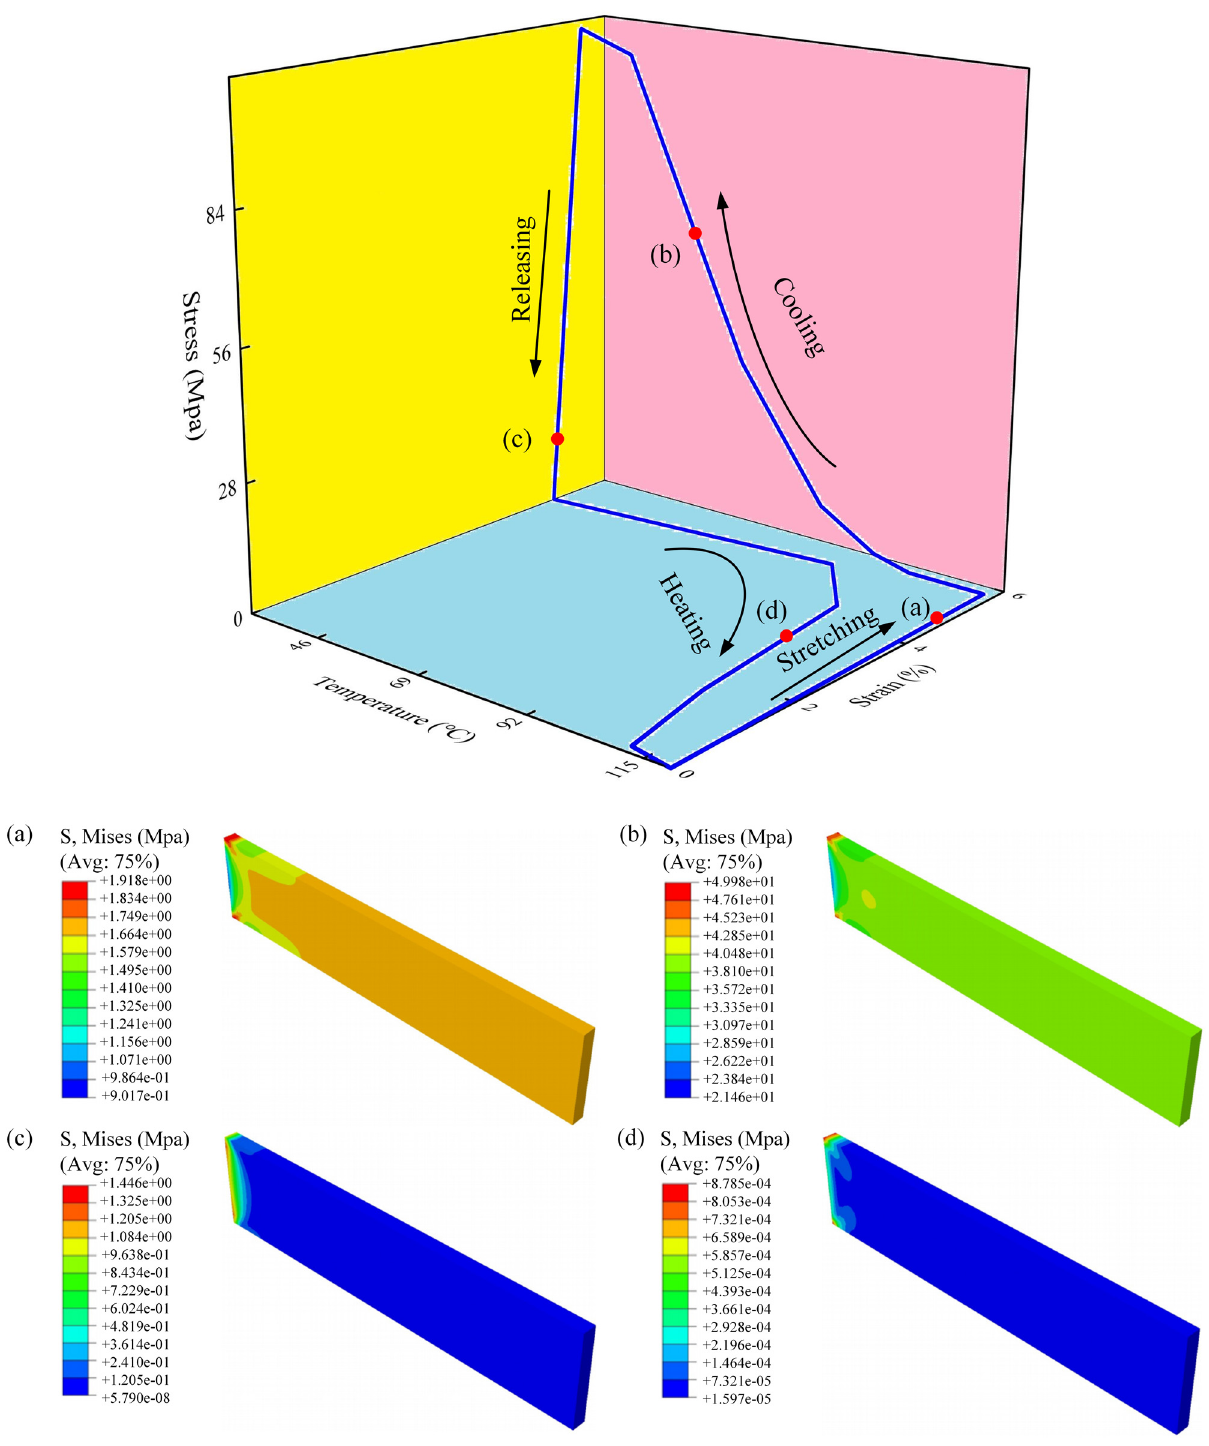
Figure 9: Three - dimensional curve of stress - strain - temperature and ( a ) to ( d ) stress distribution at state ( a ) to ( d ) of stress - strain - tem - perature